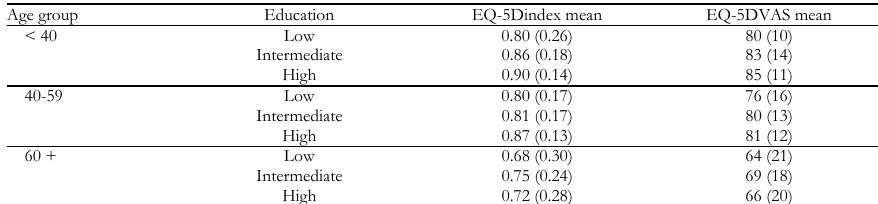
EQ-5D index mean and VAS mean for gender, age group and education